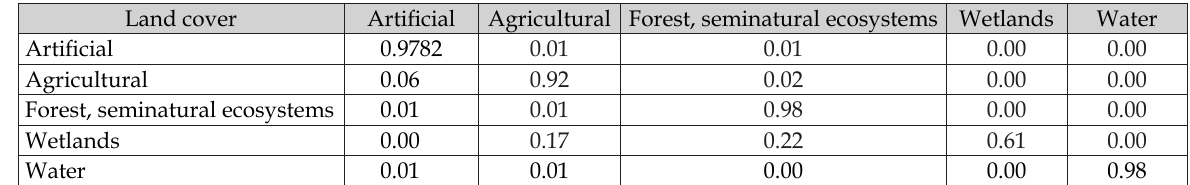
Table 5. Transition matrix between CLC 2006 and 2012.